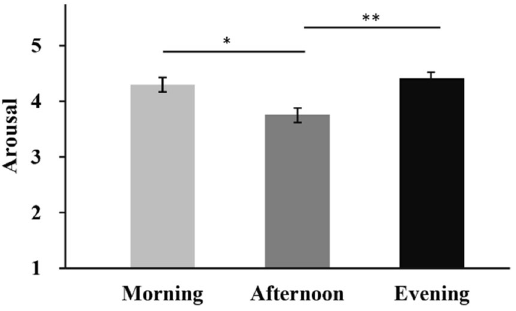
Figure 1. Pairwise comparisons for arousal level among different time-of-day. * p < 0.05; ** p <